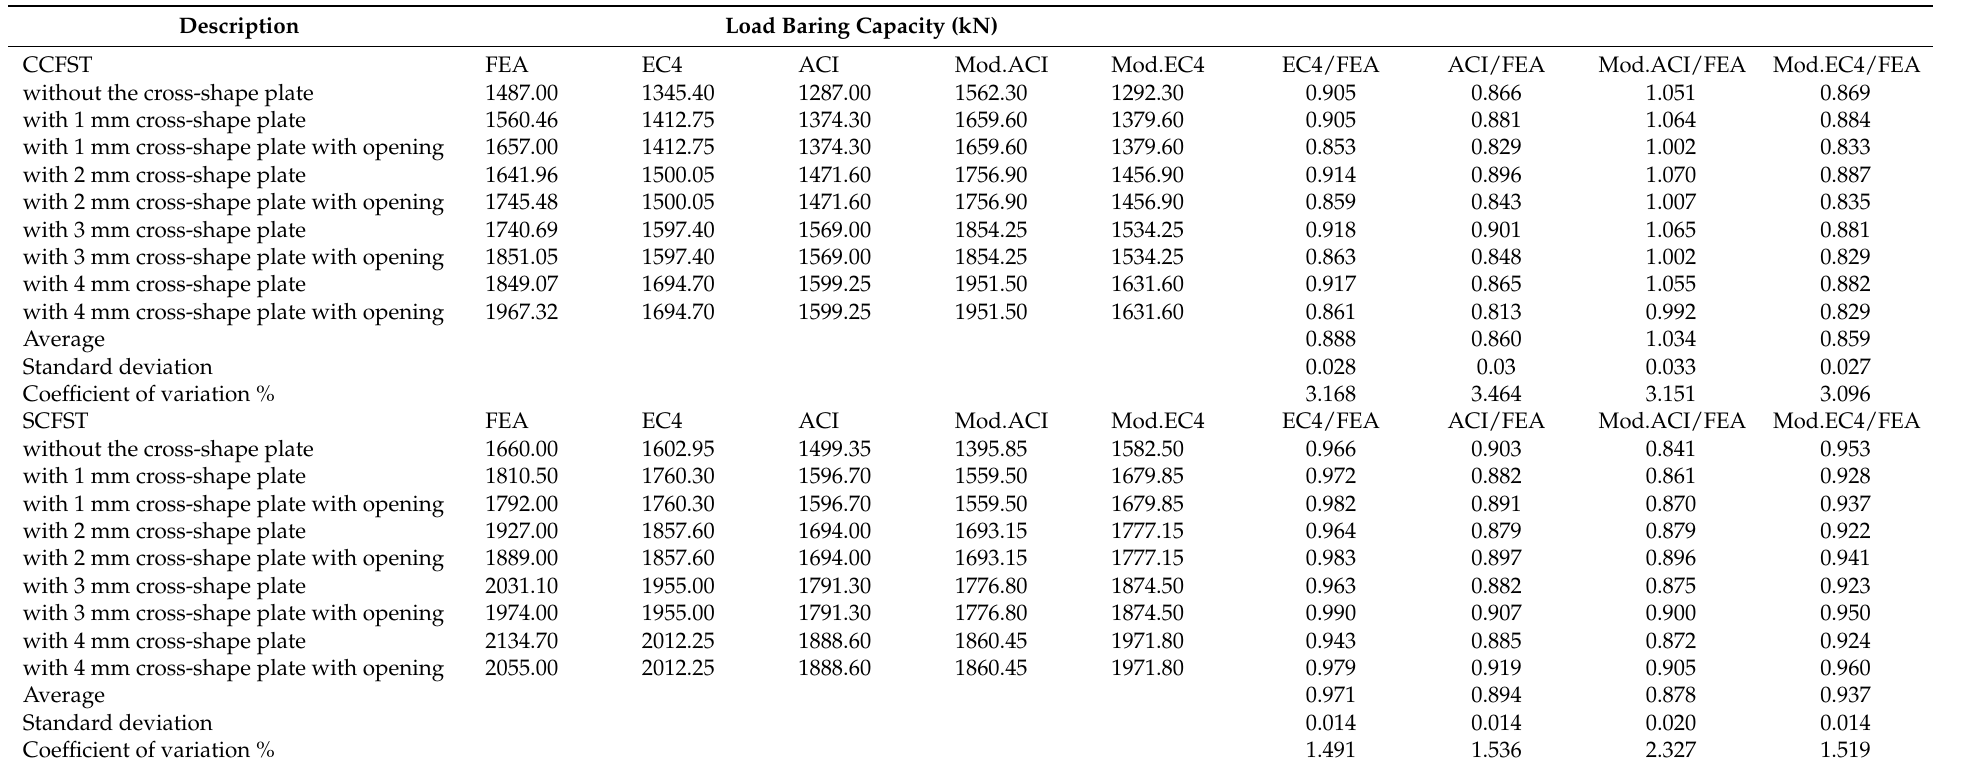
Table 8. Comparison of analysis